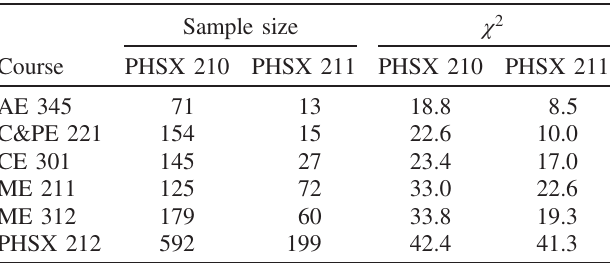
TABLE III. The summed χ 2 values calculated using Eq. (2) for students earning an A or B in the listed course from the fall semester of 2015 through the spring semester of